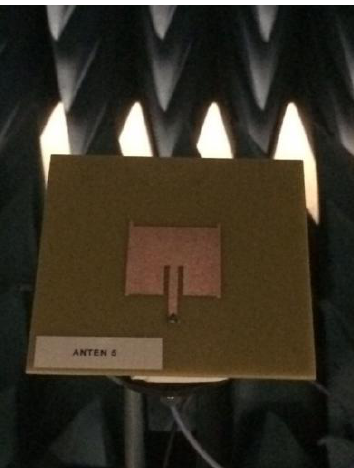
Figure 6. Fabricated antenna inside anechoic